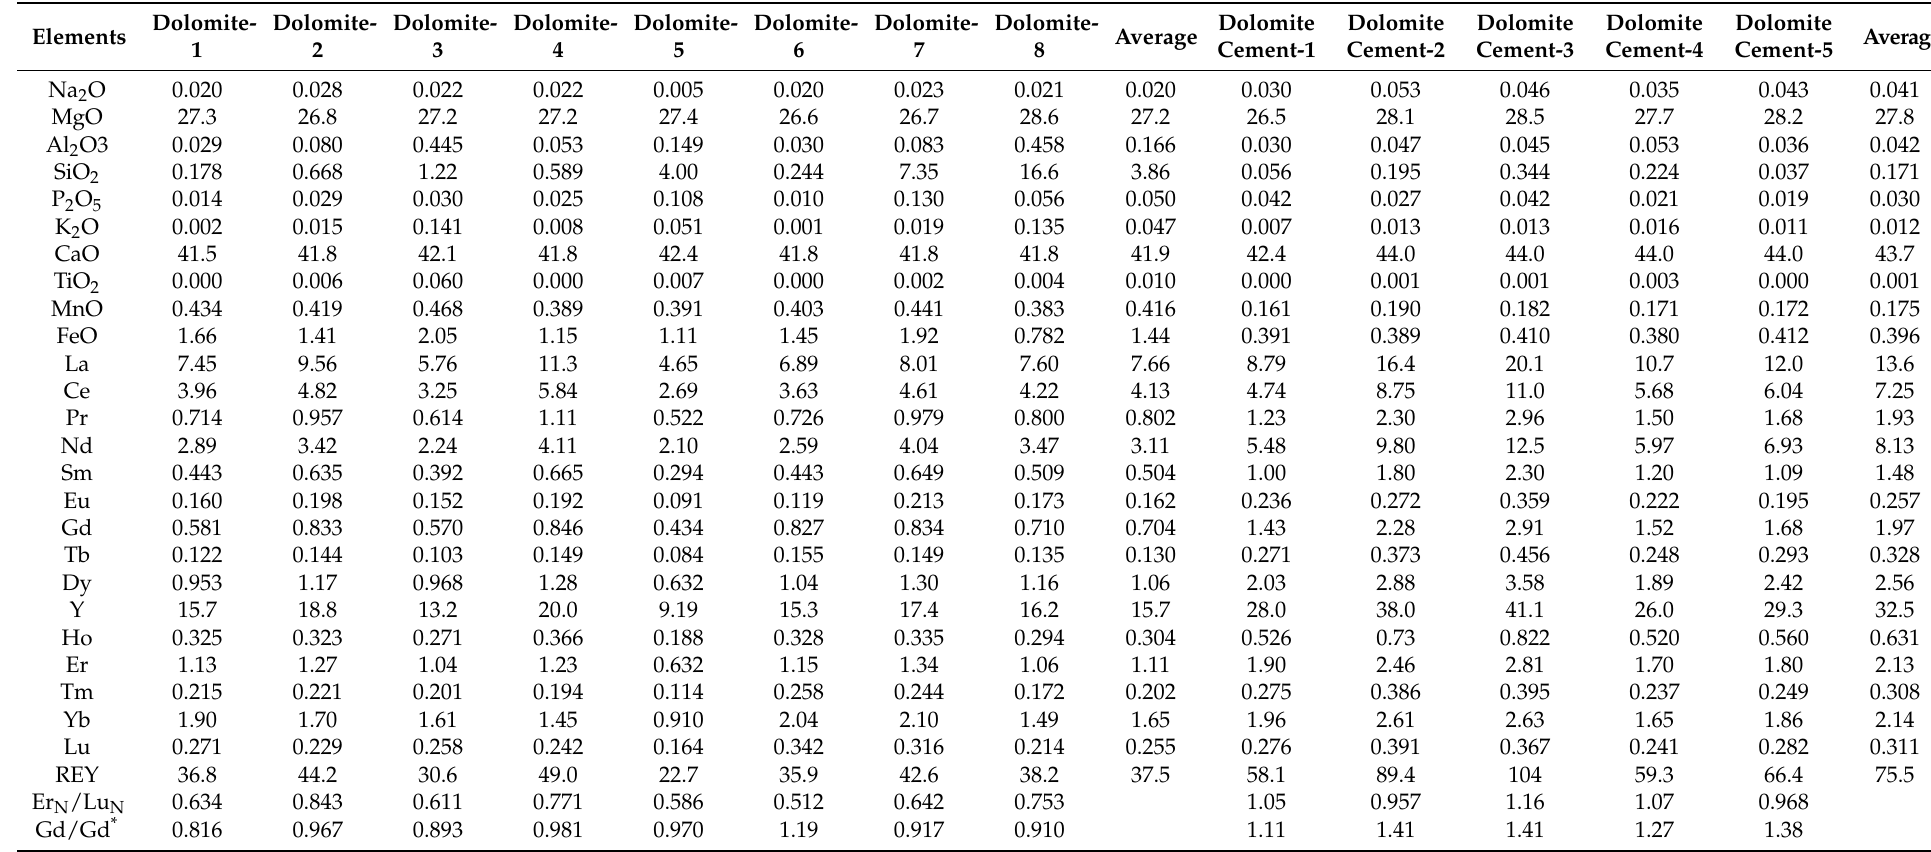
Table 3. In situ major elements (%) and REY (ppm) concentrations of dolomites from phosphorus-bearing dolostones, and phosphorites measured using